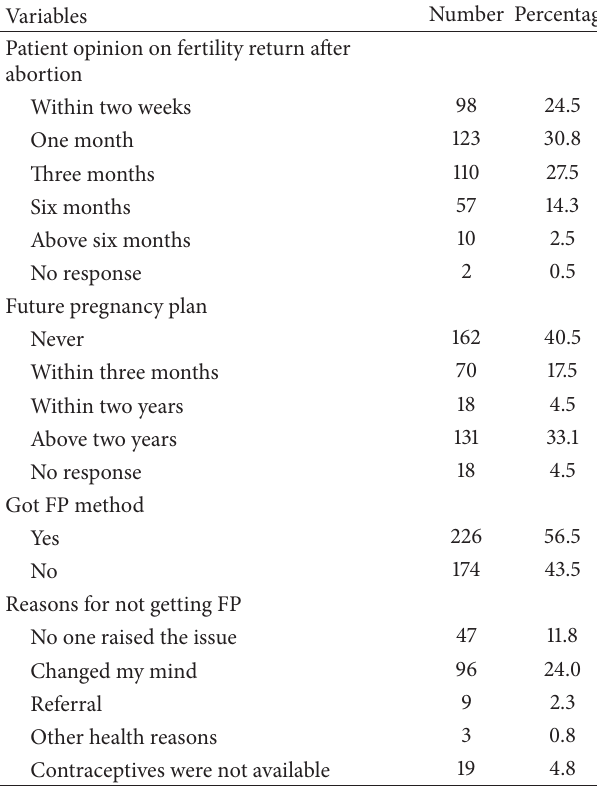
Table 4: Fertility awareness, pregnancy intentions, and family planning method provision among postabortion patients in health institution of Guraghe zone, South Ethiopia, from January to